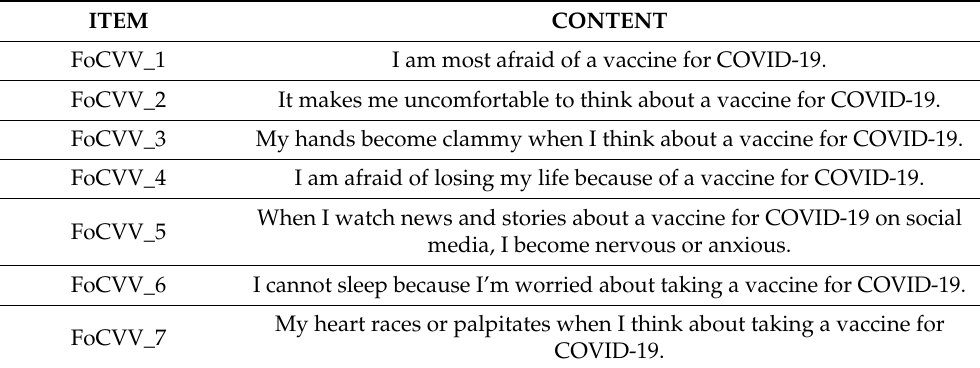
Table A1. Fear of Coronavirus Vaccination Scale (FoCVVS) in the English language. Attitude towards the Vaccination against COVID-19. Mark your answers using 1–5: 1 = completely disagree;